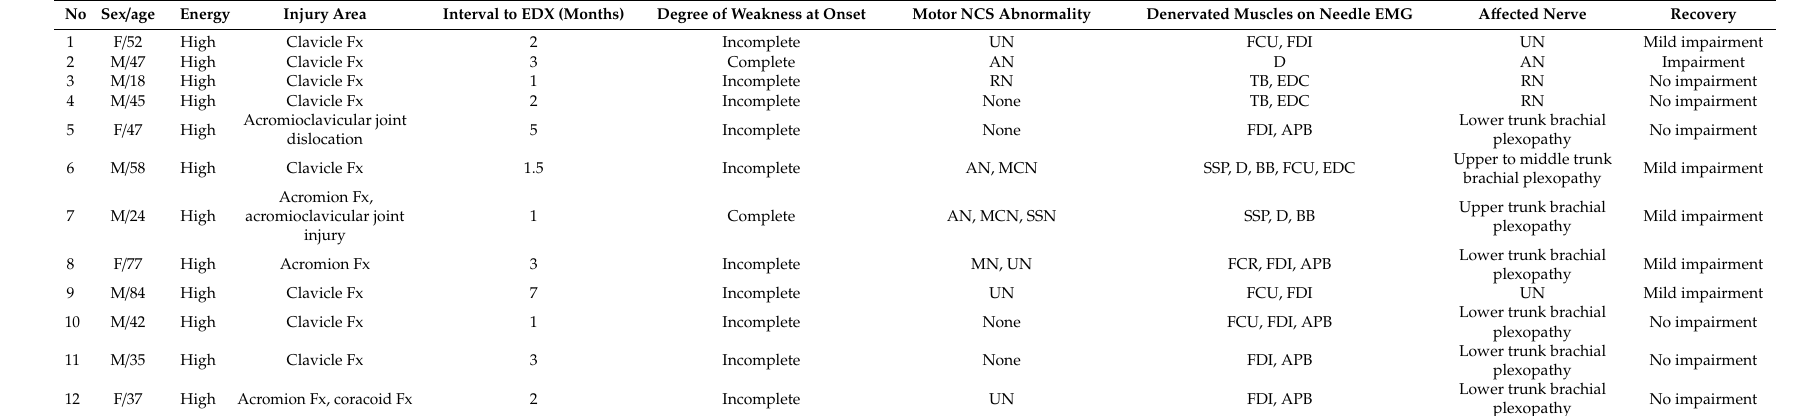
Table 3. Detailed Description of the Peripheral Nerve Injuries in 12 Patients with Acromioclavicular Injuries.